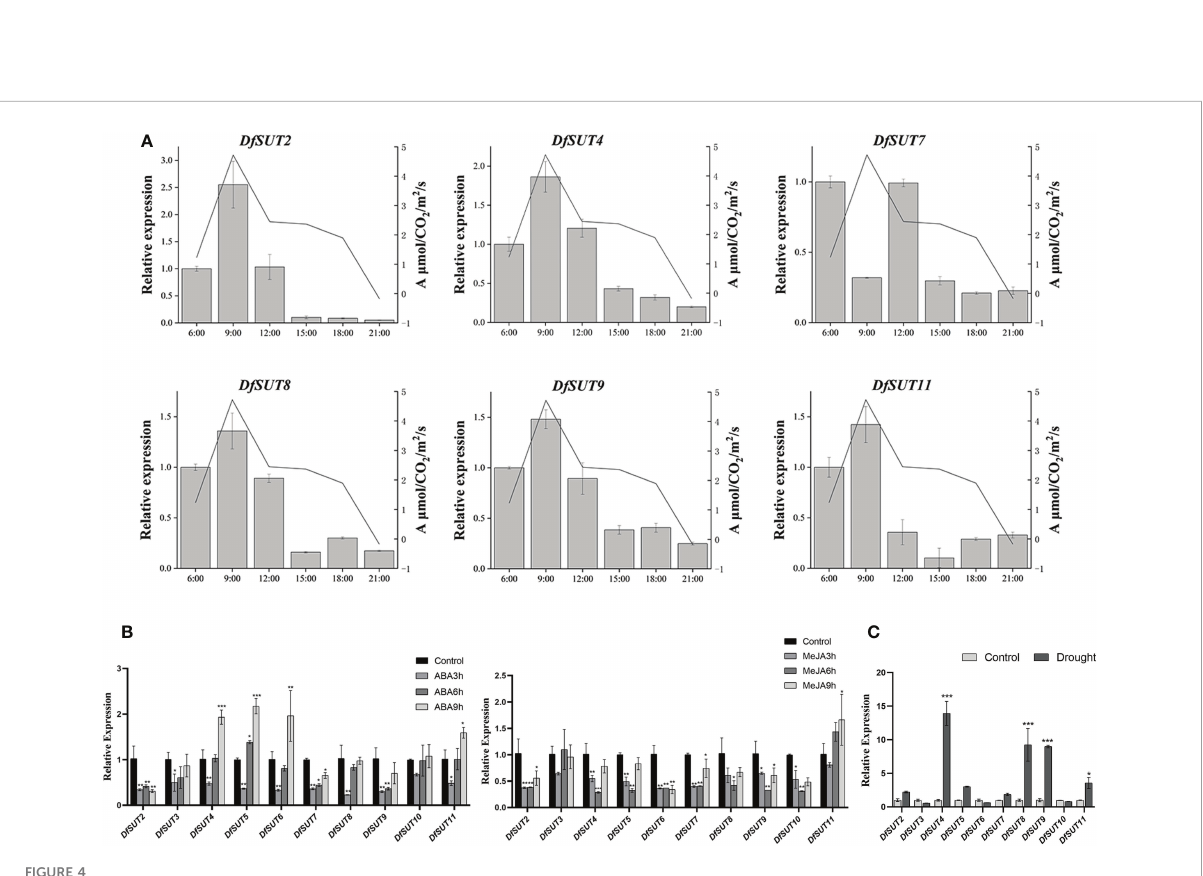
FIGURE 4 Analysis of photosynthetic rate and response to different treatments of the SUT family in D. farinosus . (A) Relative expression of DfSUT at different times of the day and the net photosynthetic reaction rate at the corresponding time periods. Total RNA was extracted from D. farinosus leaves every 3 h (from 6 a.m. to 9 p.m.) during the day. (B) Relative expression of DfSUT in response to 100 mM ABA treatment and 100 mM MeJA treatment for 3, 6, and 9 h, respectively. (C) Relative expression of DfSUT under drought treatment. *, P < 0.05, **, P < 0.01, ***, P < 0.001, Student's